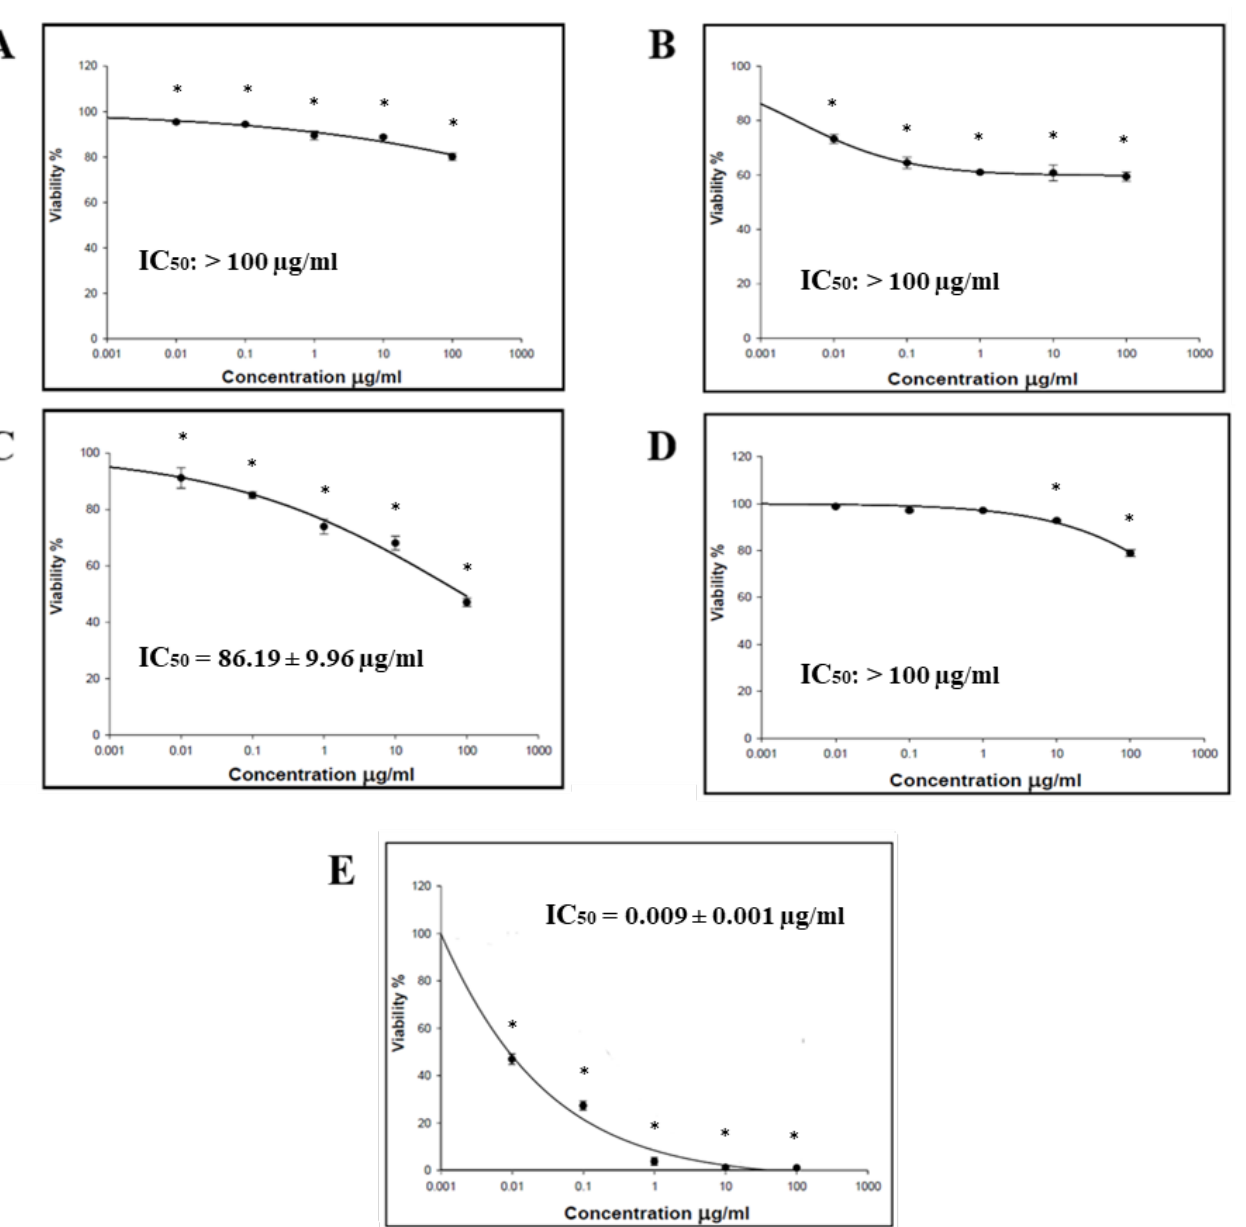
Figure 4 . Representative dose–response plots demonstrating the effect of different O. baccatus etha- nolic extracts on A549 cancer cell growth: ( A ) whole plant’s extract; ( B ) flowers’ extract; ( C ) branches’ extract; ( D ) roots’ extract; and ( E ) doxorubicin. The experiment was repeated three times. Dots and error bars represent mean ± S.D. * p < 0.05 vs. control .